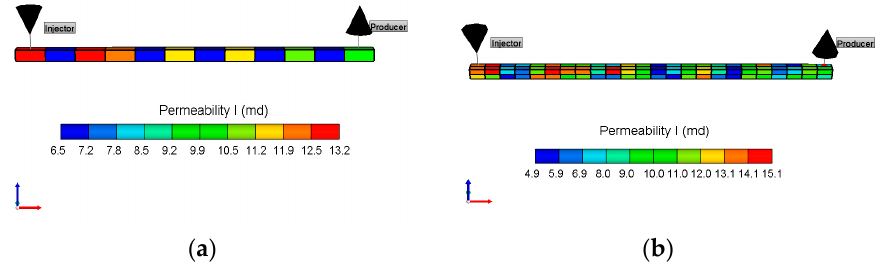
Figure 4. Permeability distribution of numerical long core model. ( a ) Simple grid; ( b ) Refined grid.